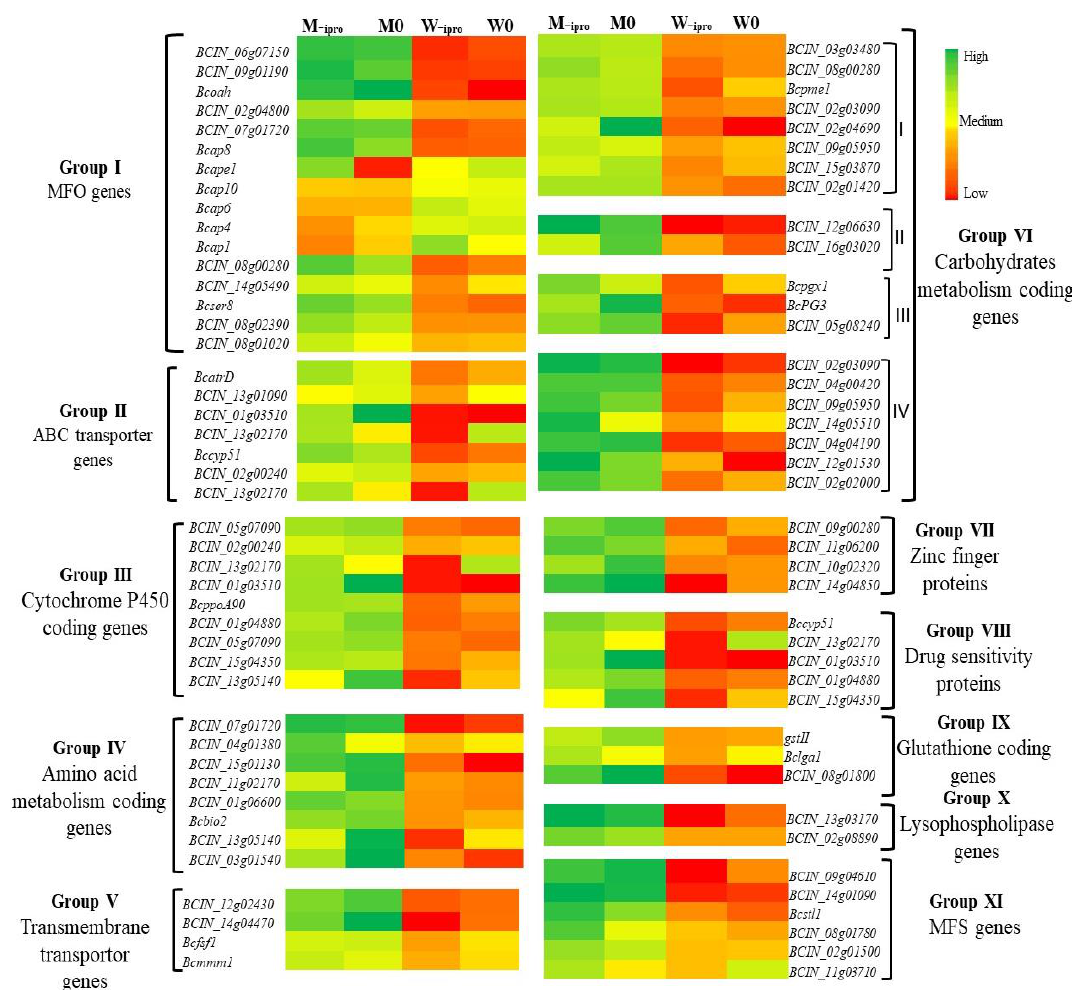
Figure 6. Variability in altered genes of wild type and its corresponding mutant with or without iprodione application represented in the form of Heat map. Genes with the same annotation modulated in a similar group. Twelve major groups are displayed in the heat map (Group I, II, III, IV, V, VI, VII, VIII, IX, X, XI, XII). Group VII have four subgroups I (Glycosyl family), II (Cellulase genes). III (Polygalacturose genes) and IV (carbohydrate metabolism).